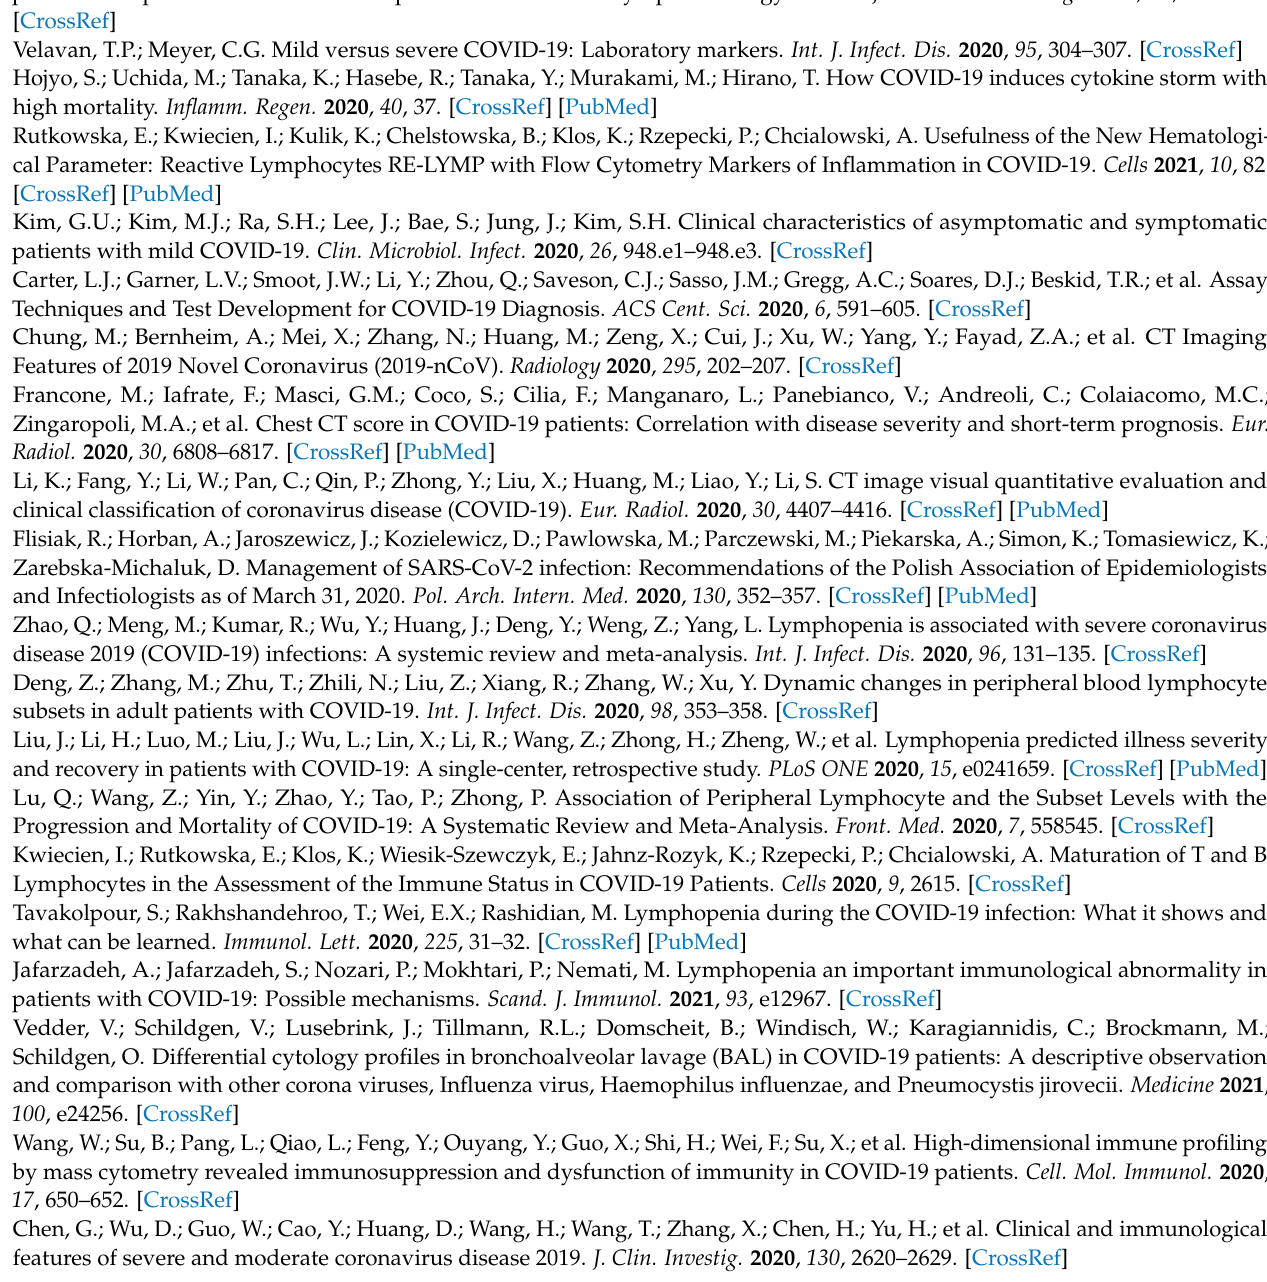
height, thus removing clumps (greater FSC-A relative to FSC-H) and debris (very low FSC), CD45 vs. SSC-A plot: Selection of lymphocytes based on their SSC/CD45+ properties. ( B ) Lymphocyte subpopulation gating strategy: CD3 vs. CD19 plot: Selection of lymphocytes T (blue and yellow) based on their CD3+ properties and lymphocytes B (navy blue) based on their CD19+ properties. CD4 vs. CD8 plot: Selection of T lymphocytes subsets CD4+ (blue) and CD8+ (yellow) based on their CD4/CD8 properties. CD3 vs. CD16 plot: Selection of NK cells (pink) based on their CD16+ properties and CD3 negative. ( C ) Treg cells and Tregs subsets gating strategy: CD25 vs. CD127 plot: Selection of Treg cells (purple) based on their CD25+high and CD127 negative properties. CD45RO vs. CD95 plot: Treg cells subset with CD45RO and CD95